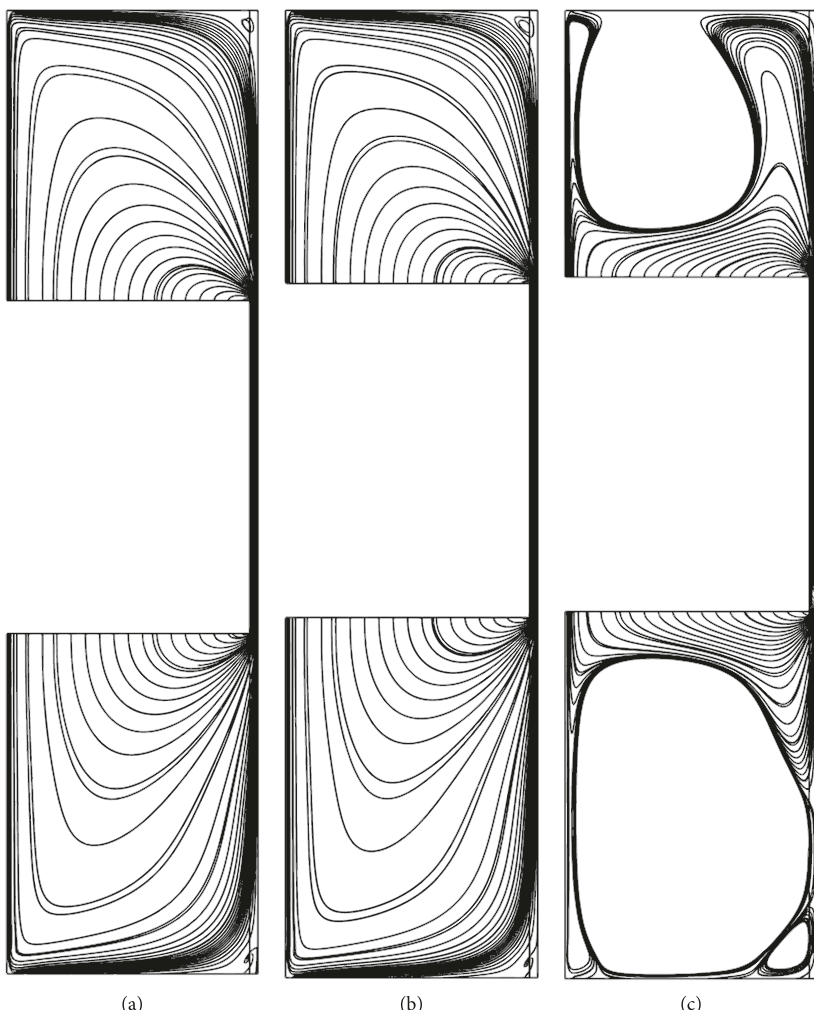
Figure 17: Stream lines within the MR damper under sinusoidal displacement excitations of 1.27cm, 0.2 Hz, 2A: (a) t � T /12; (b) t � 2 T /12; (c) t � 3 T